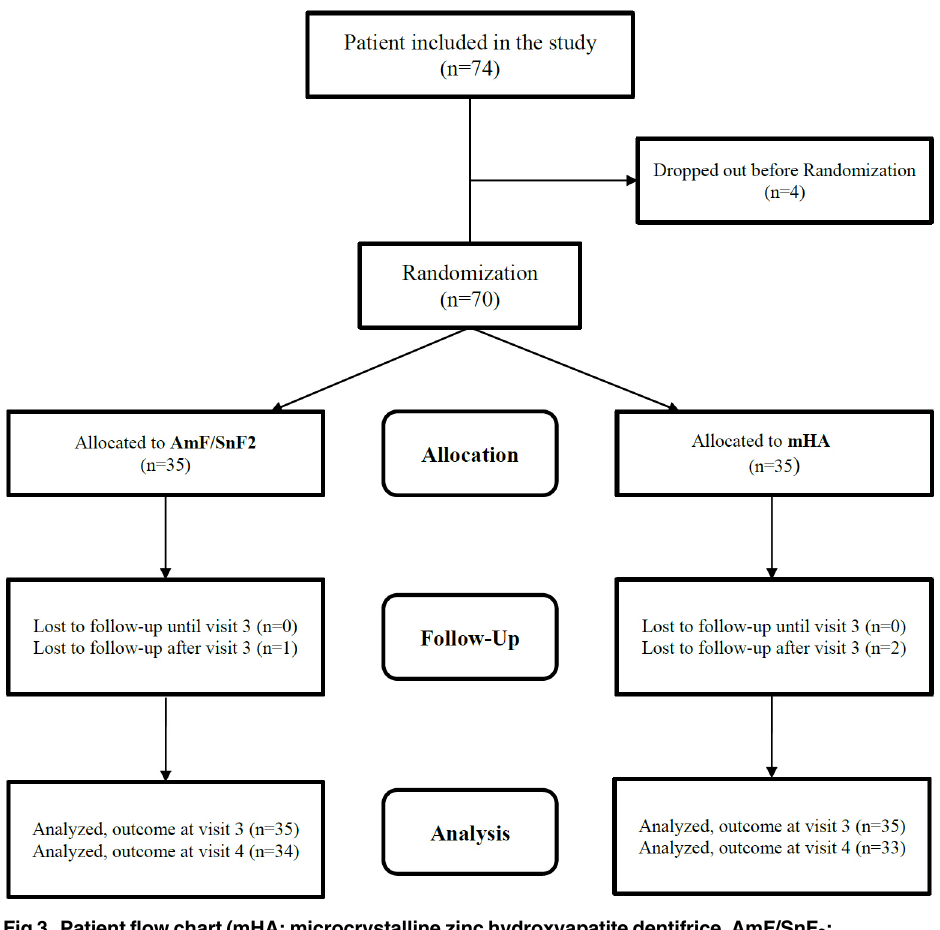
Fig 3. Patient flow chart (mHA: microcrystalline zinc hydroxyapatite dentifrice, AmF/SnF 2 : aminefluoride/stannous fluoride).